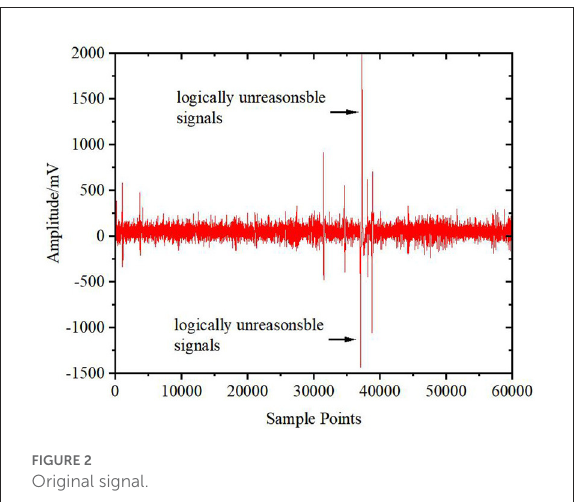
FIGURE2 Original signal.